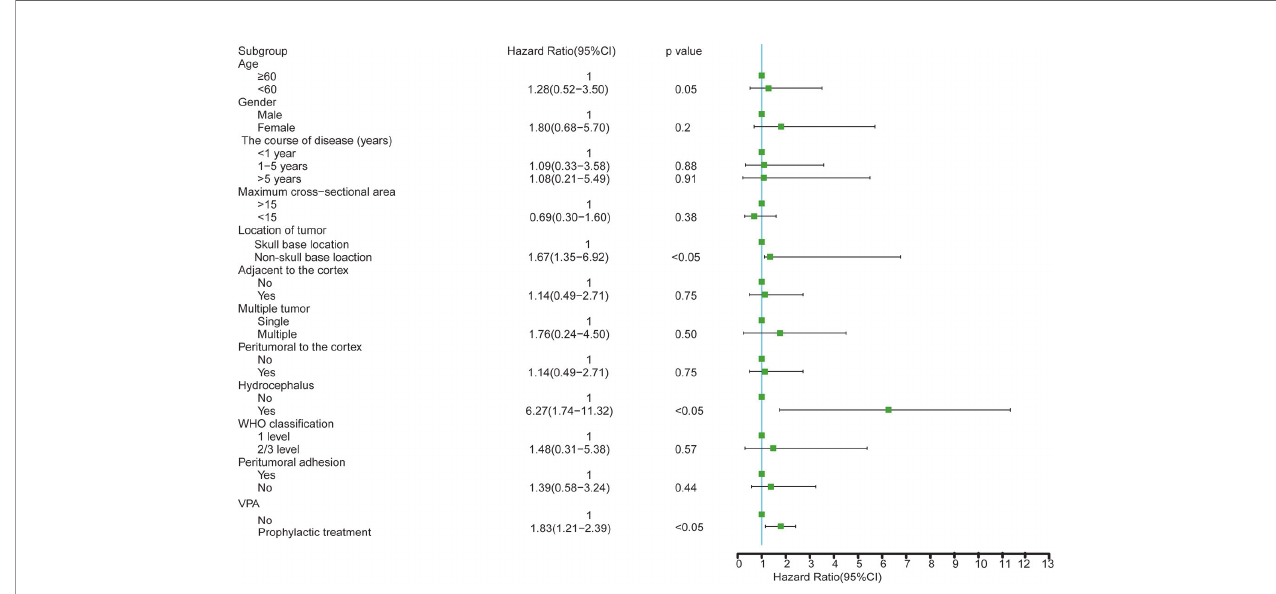
FIGURE 3 | Study population excluding the patients with seizure attack before operation for a univariate logistic regression analyses.